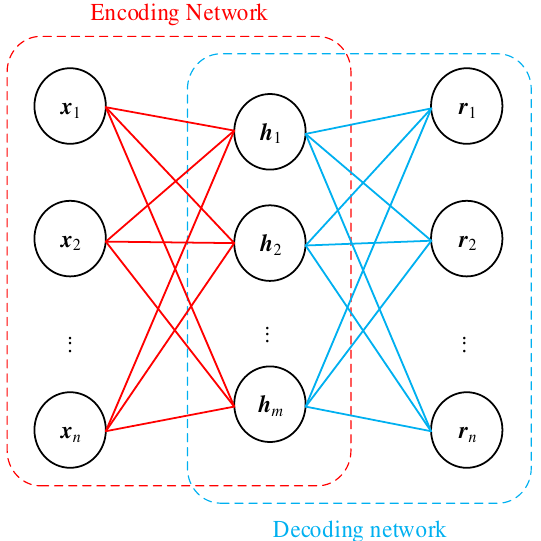
Figure 2. Schematic of the AE. However, when the dimension of the hidden layer h is equal to or greater than the dimension of the input layer x , AE cannot achieve the desired learning effect. Because of this limitation, Le et al. added sparsity constraints to the hidden layer h such that the im- proved AE could learn effectively even when the dimension of the hidden layer h was